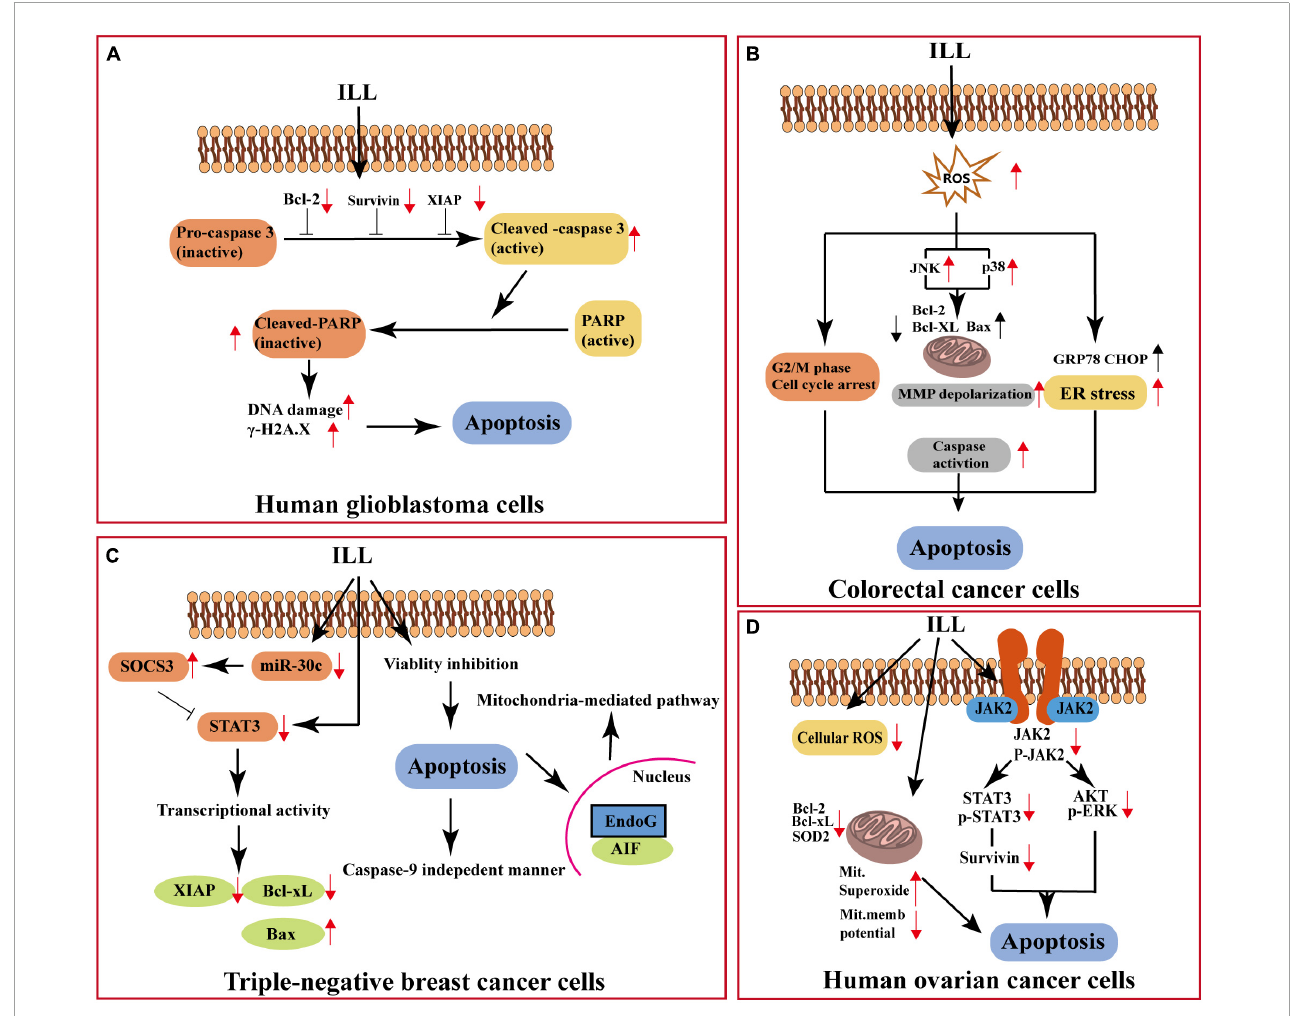
FIGURE8 Anti-cancer mechanism of action of ILL. (A) Apoptosis of human glioblastoma cells. (B) Apoptosis of colorectal cancer cells. (C) Apoptosis of triple-negative breast cancer cells. (D) Apoptosis of human ovarian cancer cells. XIAP, X-linked inhibitor of apoptosis protein; PARP, poly (AdP-ribose) polymerase; ROS, reactive oxygen species; MMP, mitochondrial membrane potential; GRP78, 78-KDa glucose-regulated protein; CHOP, C/EBP homologous protein; SOCS3, cytokine signaling 3; miR-30c, microRNA hsa-miR30c-5p; AIF, apoptosis-inducing factor; EndoG, endonuclease G; JAK2, Janus kinase 2; ERK, extracellular regulated protein kinases.